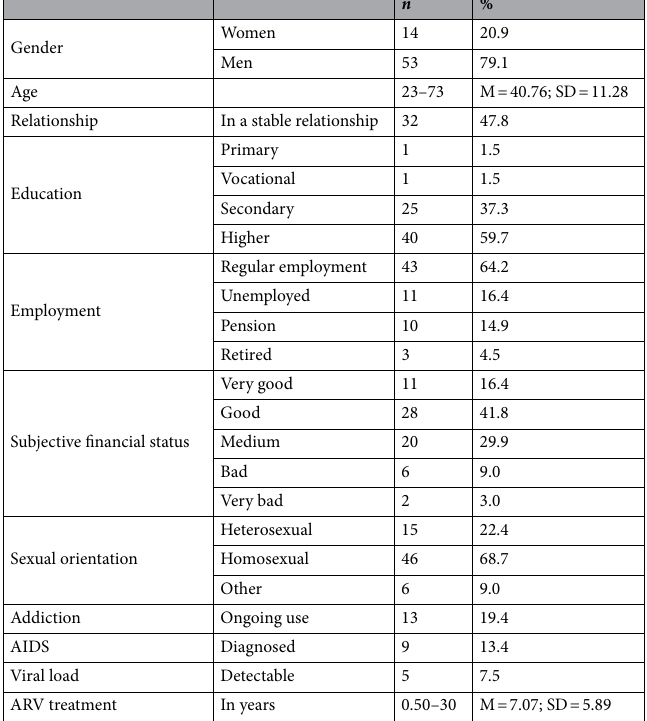
Table 1. Participants’ demographic characteristics (n = 67). M mean value, SD standard deviation, n number of participants in a